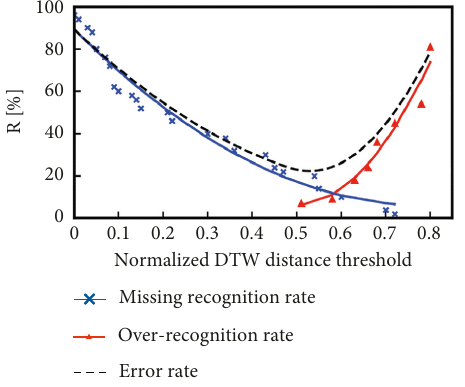
Figure 6: The relationship between the different DTW distance thresholds and error rates. The missing recognition rate is the ratio of the number of missed recognitions to the actual number of loading cycles. The overrecognition rate is the ratio of the number of nonloading cycles to the actual number of loading cycles. The error rate is the sum of